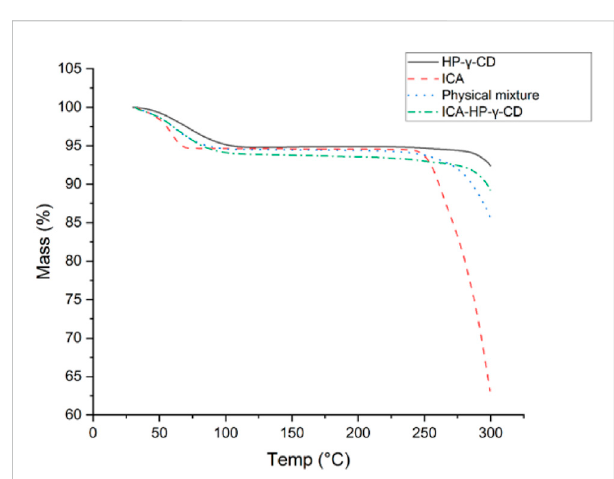
The thermogravimetric analysis of icariin, HP- γ -cyclodextrin, their physical mixture and inclusion complex.